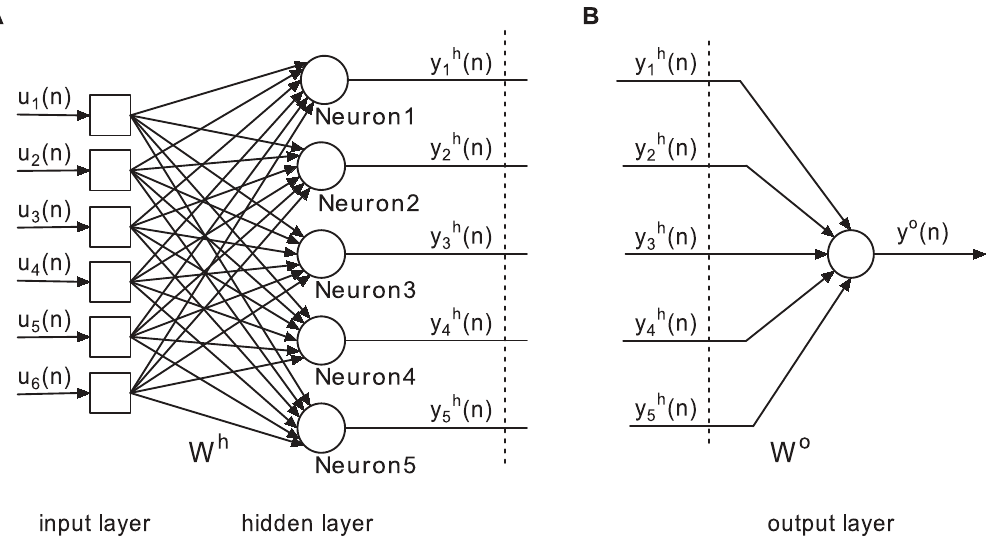
Figure 5. Decomposition of the FNN. (A) The input layer and the hidden layer of the FNN. (B) The output layer of the FNN.